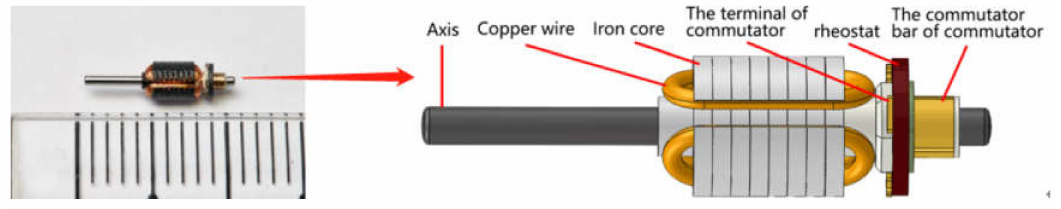
Figure 1. The inspected